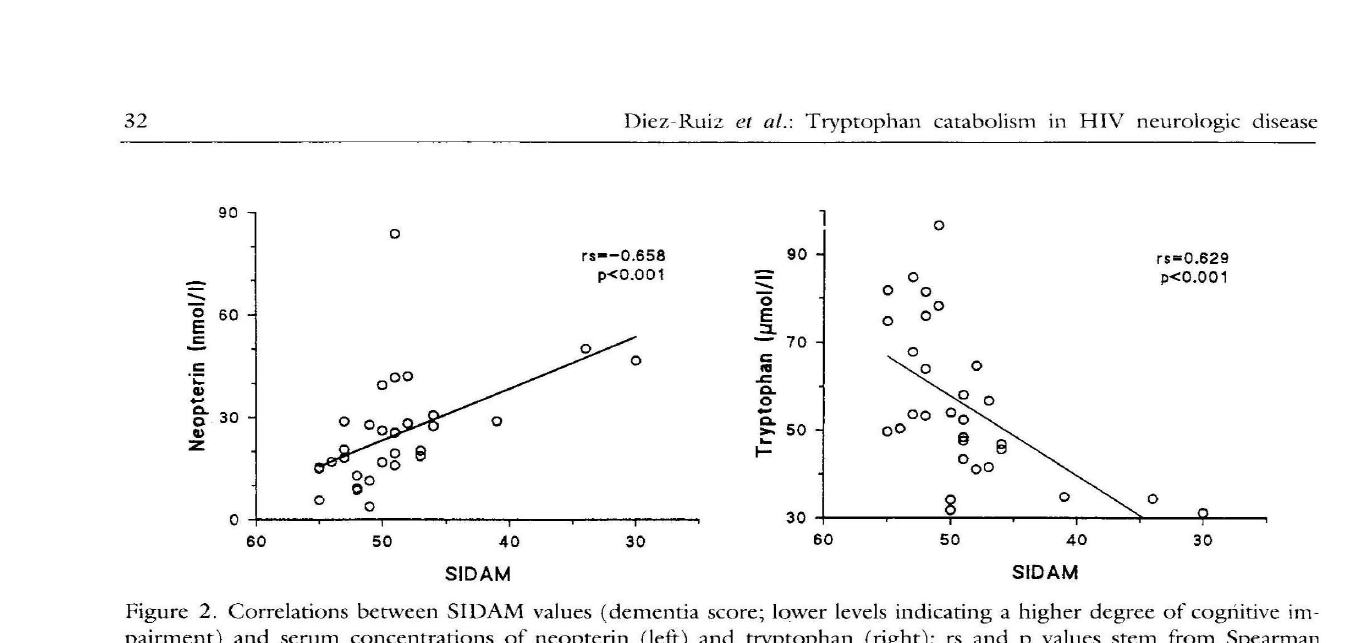
Figure 2. Correlations between SIDAM values (dementia score; lower levels indicating a higher degree of cognitive im pairment) and serum concentrations of neopterin (left) and tryptophan (right); rs and p values stem from Spearman rank correlation